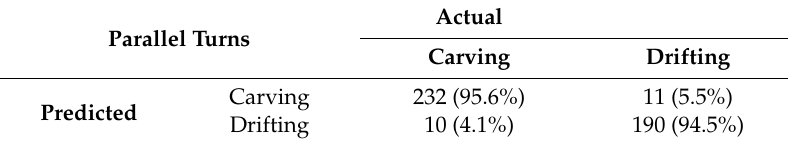
Table 8. Confusion matrix for parallel turns—Gradient boosted tree.